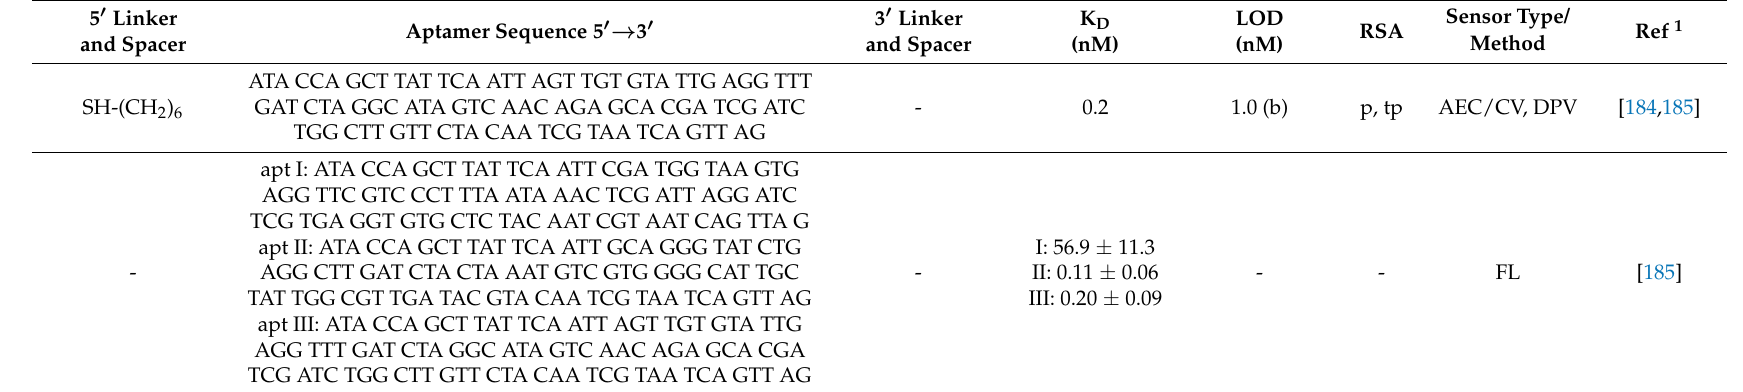
Table 13. Aptamer sequence, dissociation constant (K D ), limit of detection (LOD), real sample analysis (RSA), and realized sensor type and measuring method for oflofloxacin, mentioned in the corresponding references (Ref). AEC = amperometric electrochemical, b = buffer, CV = cyclic voltammetry, DPV = differential pulse voltammetry, FL = fluorometric, p = pork, and tp = tap